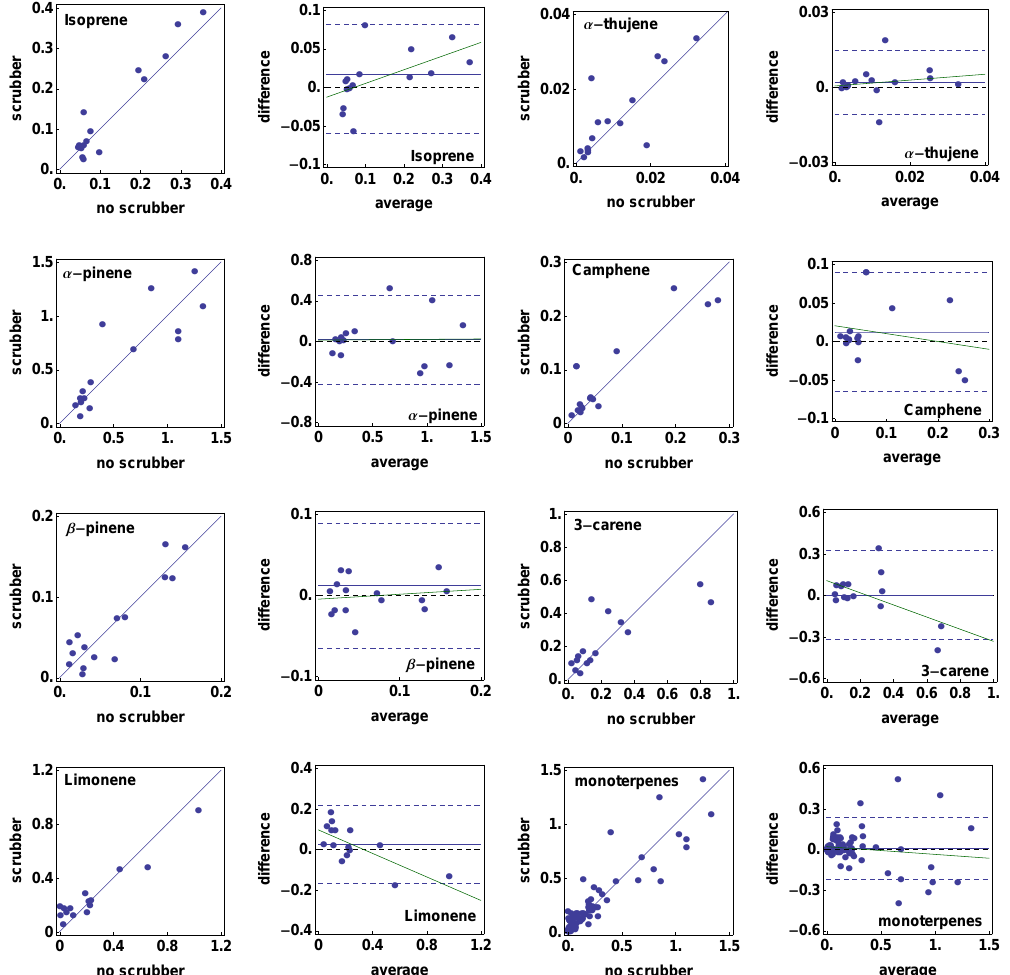
Fig. 6. Comparison between the two measurements conducted with (scrubber) and without (no scrubber) ozone removal according to the method of Bland and Altman (1999). For each one, isoprene, several monoterpenes and the combined dataset for monoterpenes, a pair of plots are presented. The first compares the parallel measured pairs to identity line ( y = x ) and the second one shows the difference between the samples (no scrubber – scrubber) against the average between the samples. The dashed black line marks zero, the blue line the mean difference and the dashed blue lines the 95% limit of agreement. The offset of the mean difference of the samples to zero is a measure of the bias between the two sampling methods. The green regression line shows a possible dependency between the difference of the sample method and their sampled average concentration. All units are given in µgm − 3 .